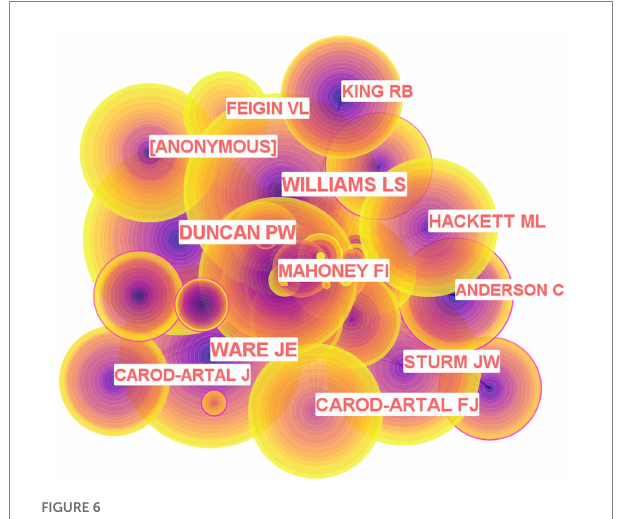
FIGURE 6 Map of co-cited authors with publications.